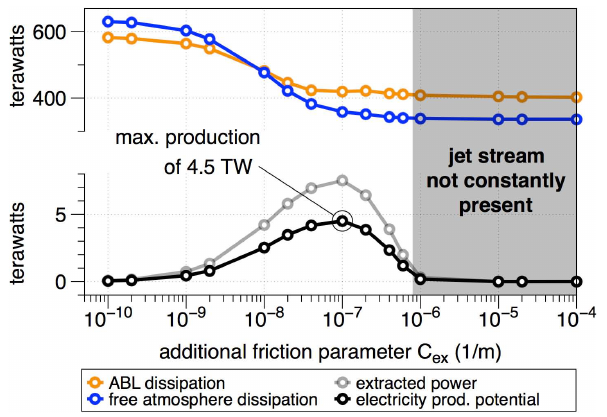
Fig. 4. Sensitivity of extracted kinetic energy from jet streams Pex and total atmospheric dissipation D n to the additional drag C ex im- posed by wind turbines.